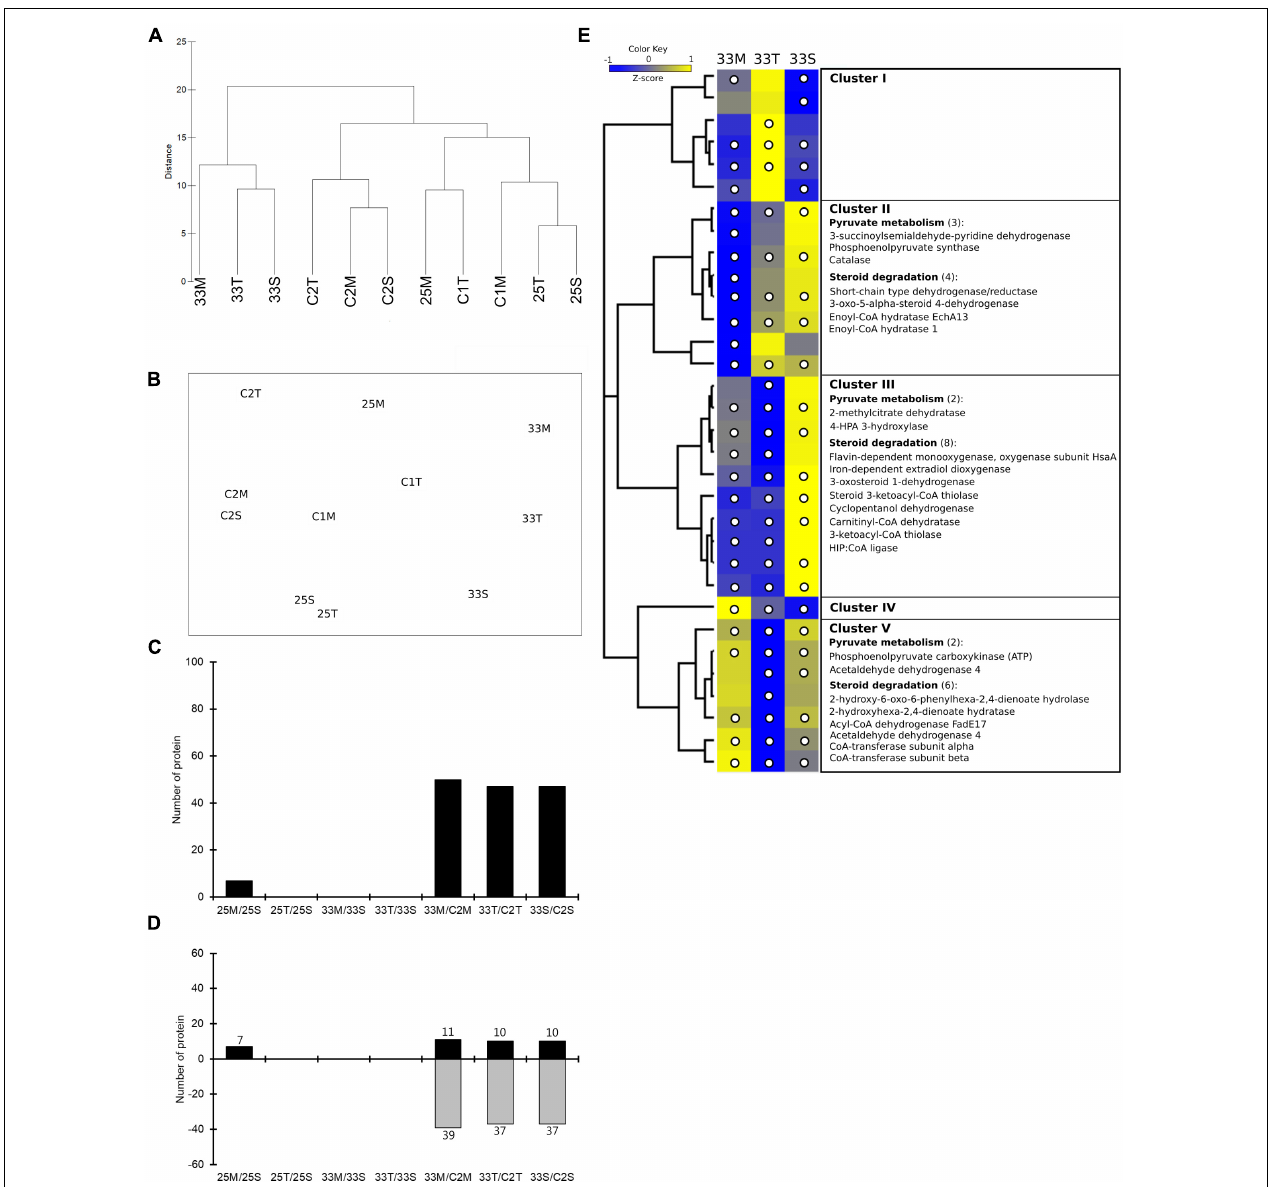
FIGURE 3 | Quantitative proteomics analysis of coral lysate incubated with bacterial cultures at different temperatures. (A) Hierarchical clustering and (B) nMDS ordination of different samples similarities. (C) The number of significantly changed proteins that were affected by coral lysate (25M/25S, 25T/25S, 33M/33S, and 33T/33S) and temperature (33M/C2M, 33T/C2T, and 33S/C2S). (D) The number of proteins with increased and decreased expression in each comparison. (E) Hierarchical clustering heatmap visualization of the metabolism-related (from COG functional categories) proteins that have significantly changed in any of the three treatments (33M/C2M, 33T/C2T, and 33S/C2S). The columns names (33M, 33T, and 33S) represent three treatments. Relative protein abundance ( z -score transformed) is graded from low (blue) to high (yellow) in each row. The bracketed numbers represent the number of proteins if there are multiple proteins in a category. The significantly changed proteins are marked by a white circle.